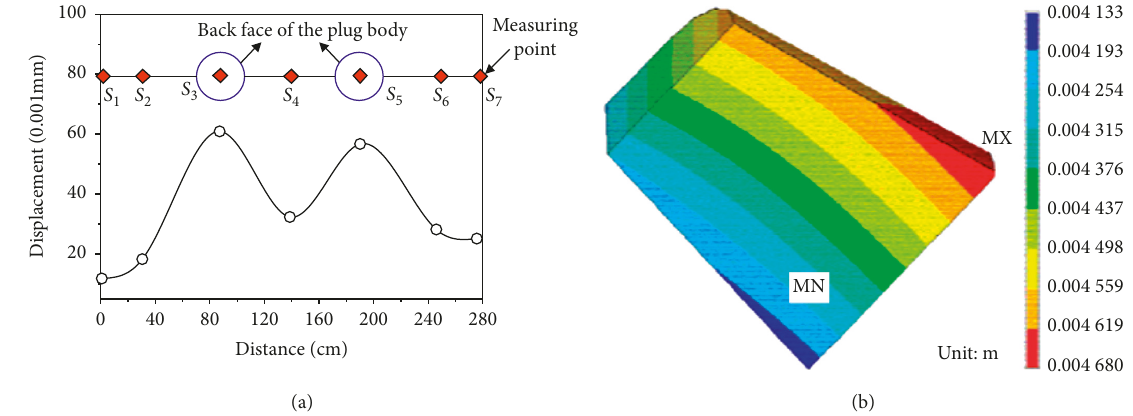
Figure 5: (a) Surface displacement of the rock mass on the back end of the plug body in the pull direction [33, 37]. (b) Axial displacement of plug body [41].